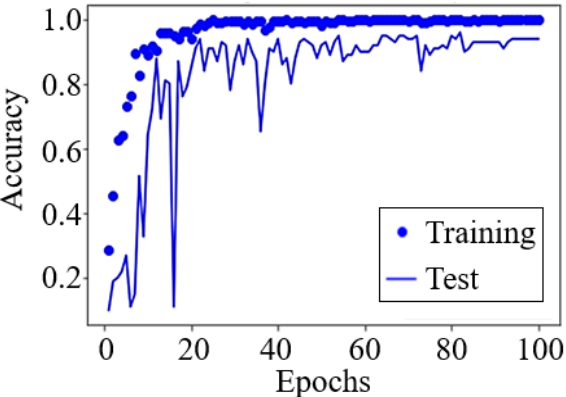
Figure 8. Sample learning curve of the CNN method using the dual radar data. Table 2. Confusion matrix of the CNN method.